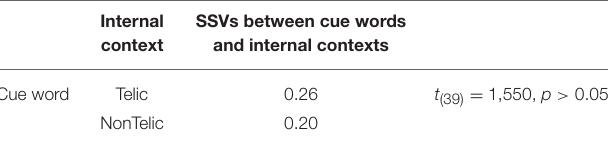
TABLE 5 | Semantic Similarity Values (SSVs) between the cue words and the internal